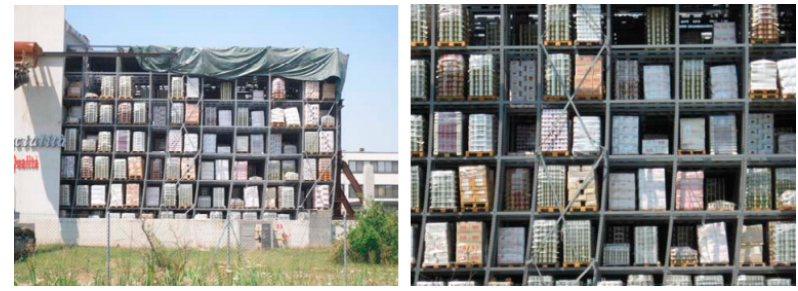
Figure 4. Seismic deformations of steel scaffolding systems [1].